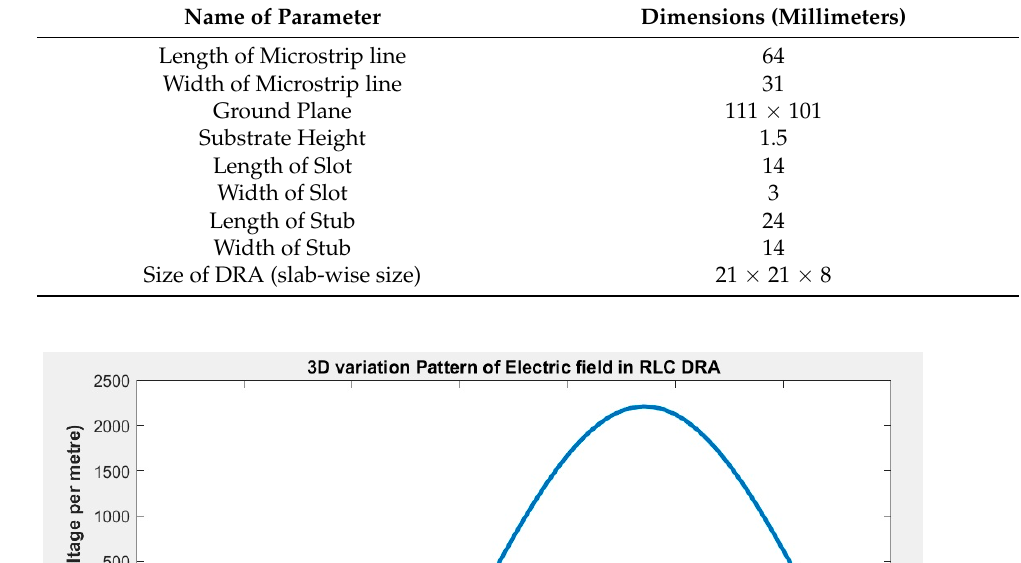
Table 1. Parameter information of proposed multi-stacked DRA.